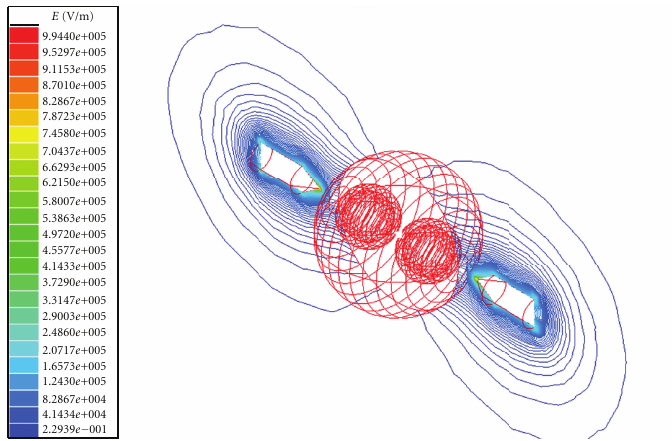
Figure 4: Electric field distribution for breast lobe tissue with tumor cells (needle electrodes).